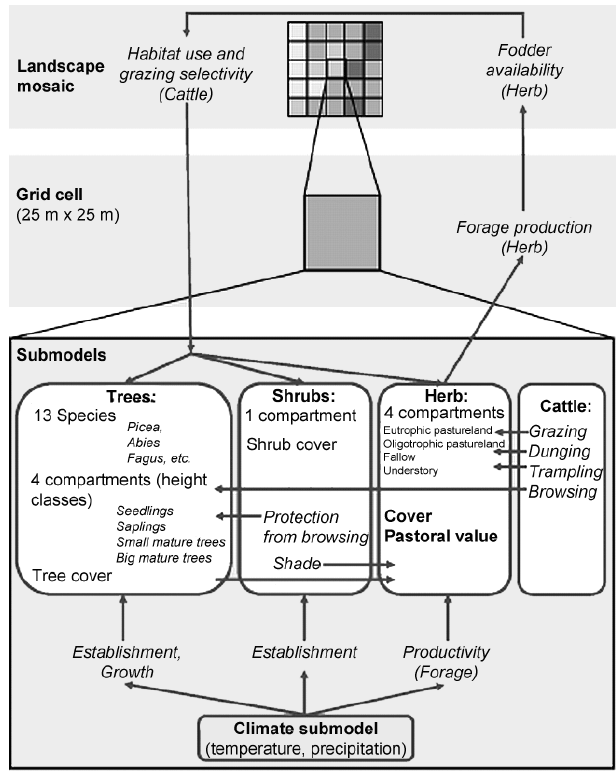
Fig. 1 . Structure of the WoodPaM model and main interactions (arrows) among submodels (in horizontal direction) and across spatial scales (in vertical